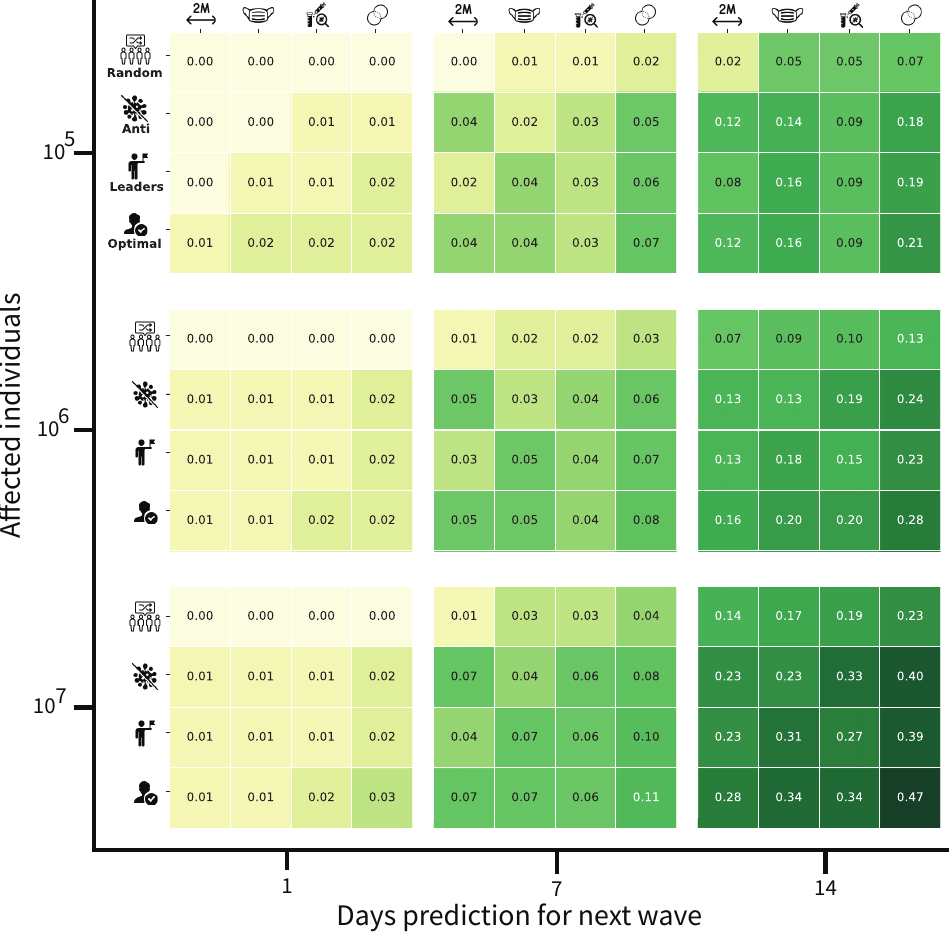
Figure 6. Four-dimensional analysis of the social PIP. The first dimension is the delay between a prediction and the beginning of an epidemiological wave. The second is the number of affected indi- viduals, as a function of the PIP’s budget. The third dimension relates to the PIP which is promoted by the social PIP. Forth is the social PIP’s strategy. The non-social PIPs are social distancing (SD), mask-wearing, vaccination, and all three (combined). The social PIP strategies include advertising